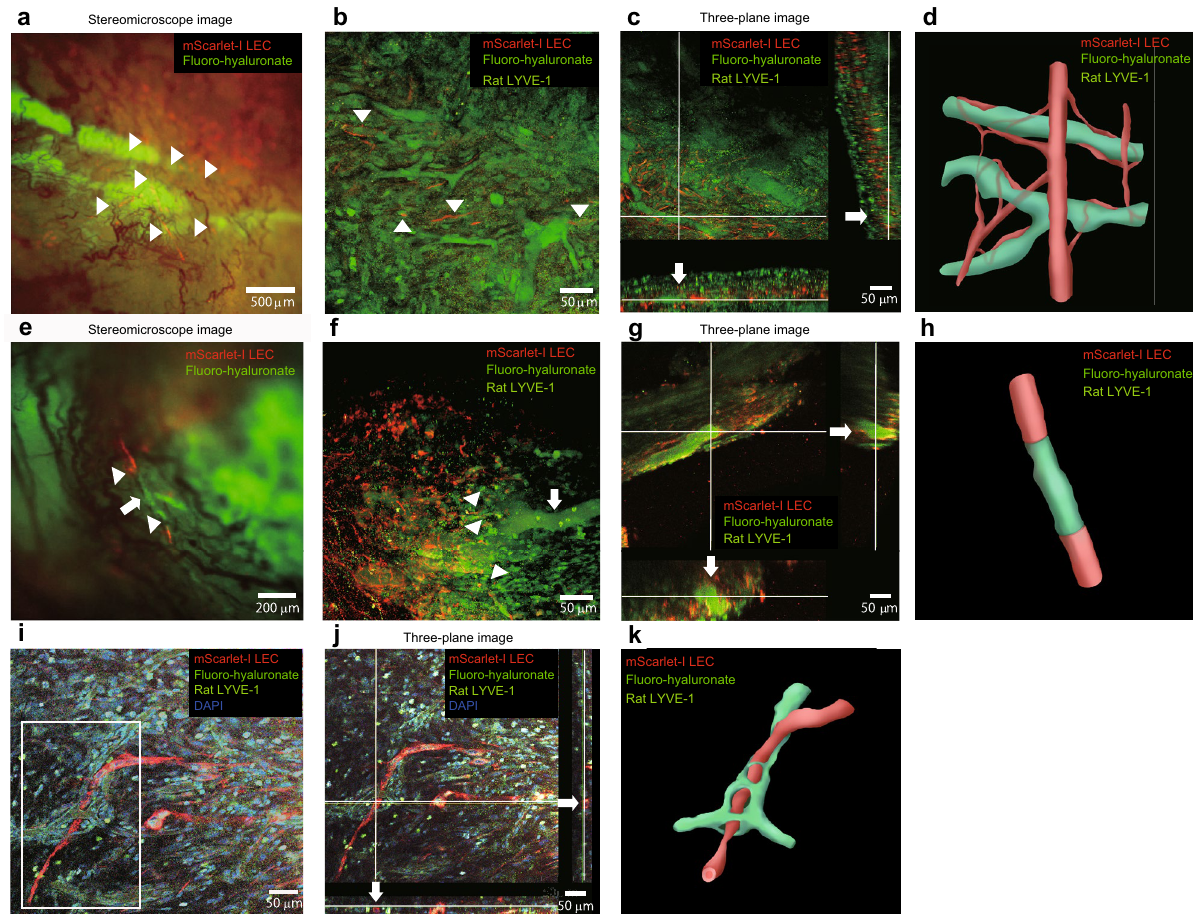
Figure 6. Analysis of the direct contribution of transplanted cells to lymphatic vessel reconstruction using a two-photon laser microscopy system. ( a ) Stereoscopic fluorescence microscopy image of a cell sheet containing a localized network of LECs obtained 1 week after transplantation. Interactions (arrowheads) are evident between fluoro-hyaluronate-containing host lymphatic vessels (green) and the transplanted LEC network (red). ( b ) Image of the structure in ( a ) obtained by two-photon laser microscopy after tissue clearing. The arrowheads show regions where transplanted LECs (red) formed parts of the walls of host lymphatic vessels (immunostained for rat LYVE-1; green) that had taken up fluoro-hyaluronate (green). ( c ) Three-dimensional two-photon laser microscopy of the structure in ( b ) after tissue clearing (three-plane image). At the intersection of the white lines, transplanted LECs (red) were observed in the wall of a host lymphatic vessel (arrows) that contained fluoro-hyaluronate (green). ( d ) Stereofluorescence microscopy image of a cell sheet construct with a localized network of LECs at 1 week after transplantation. The arrowheads show end-to-end connections between a fluoro-hyaluronate-containing host lymphatic vessel (green) and transplanted lymphatic endothelium (red). ( e ) Image of the structure in ( d ) acquired with two-photon laser microscopy after tissue clearing. mScarlet-I-labeled LECs partially co-localized with rat LYVE-1-positive host lymphatic vessels that contained fluoro-hyaluronate, suggesting that the transplanted LECs formed part of the lymphatic vessel wall (arrowheads). ( f ) Three-plane image of the structure in ( d ) captured by two-photon laser microscopy after tissue clearing. At the intersection of the white lines, the fluoro-hyaluronate-containing lymphatic vessels (green) were observed to have a vascular wall composed of transplanted LECs (red) (arrows). Yellow signals indicate anastomoses of rat LECs and transplanted human LECs composing functional lymphatic vessels (arrows). ( g ) Two-photon laser microscopy image obtained after tissue clearing. The transplanted mScarlet-I-labeled LECs (red) were connected to each other as a chain of cells. The region in the white rectangle shows the newly formed human lymphatic vessel (comprising mScarlet-I-labeled LECs) intertwining with the lymphatic vessels of the host rat (immunostained for rat LYVE-1). Cell nuclei are stained with DAPI. ( h ) Three-plane image of the structure in ( g ) obtained by two-photon laser microscopy after tissue clearing. At the intersection of the white lines, the transplanted human LECs (red) formed a vessel with a lumen (arrows). ( i ) Illustration of the morphology of the structure in ( g ). The lymphatic vessels of the host rat are shown in green, and the vessel formed by the transplanted human LECs is shown in red. Remodeling of the lymphatic vessels had resulted in the vessels intertwining with each